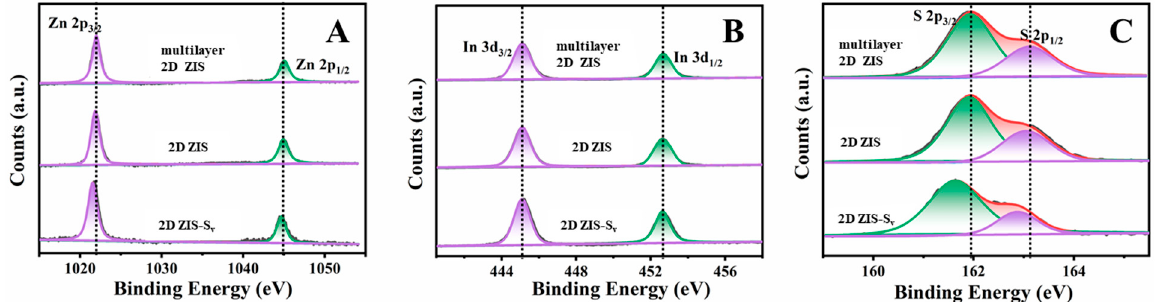
Figure 2. High ‐ resolution XPS spectra for Zn ( A ), In ( B ), and S ( C ) of 2D ZIS, 2D ZIS ‐ S v, and multi ‐ layer 2D ZIS.